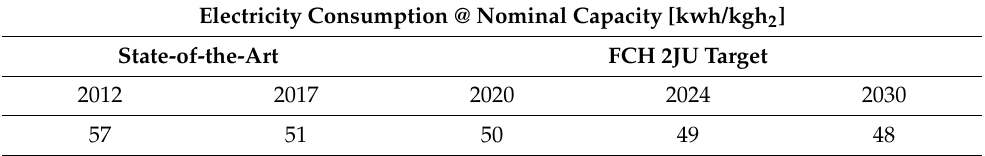
Table 1. Large scale electrolyser current and future objectives for electrical energy consumption per each kilogram of hydrogen produced at nominal capacity [10].